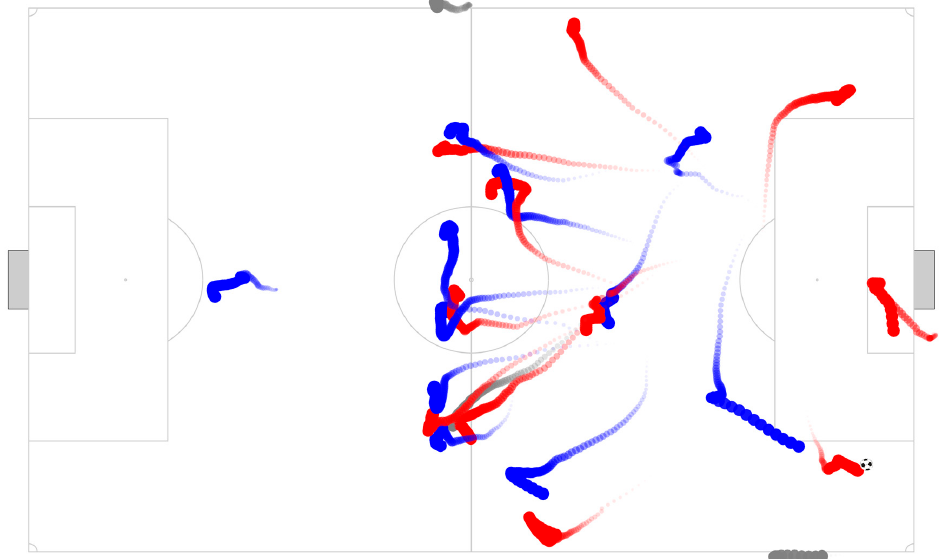
Figure 1. Match frame animation. Teams are colored with blue and red, and referees in grey. Each track shows a delay position of 15 s, which represents 75 data points (15 s * 5 Hz). For each data point, an exposure score was attributed according to the time position.